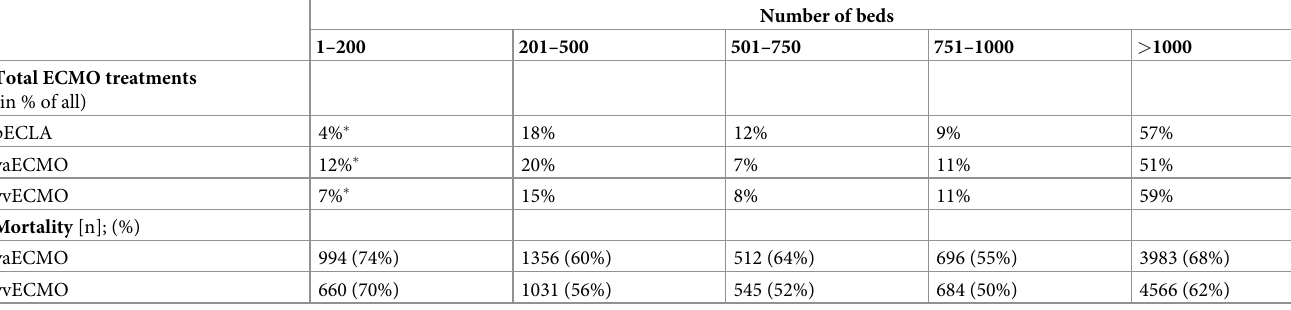
Table 2. Total ECMO treatments and mortality by hospital size from 2010 to2016.